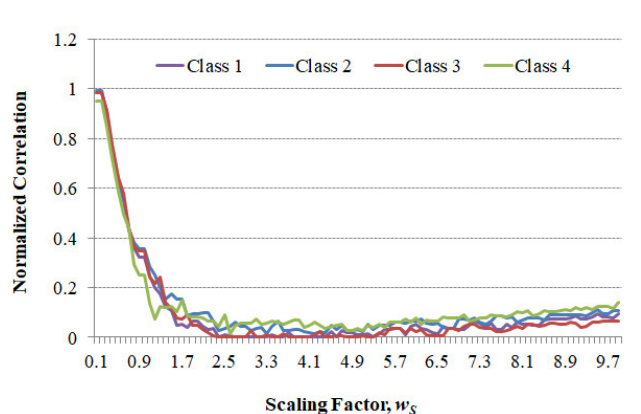
Figure 10. NC values and scale factor of the second Fresnel transform at the transform distance 20 m in the proposed digital hologram encryption technique.